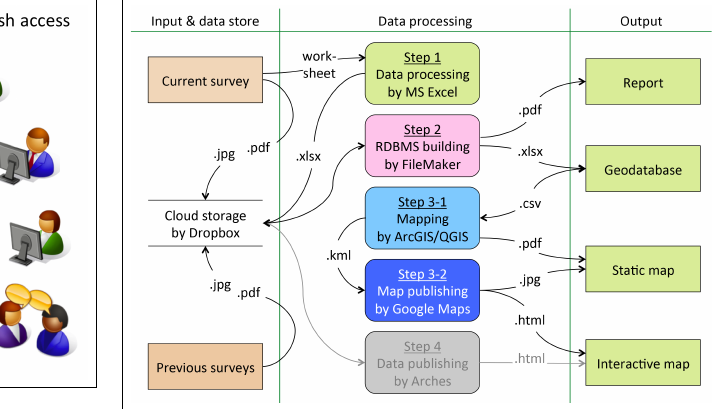
Figure 2: Data flow in the BatDHI